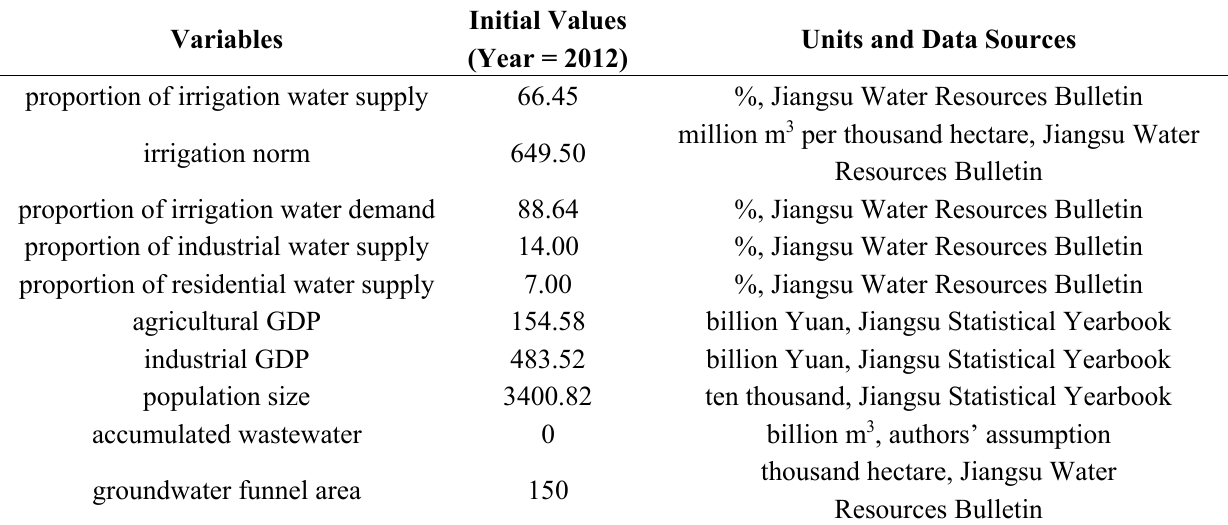
Table 1. Initial values and sources of some key